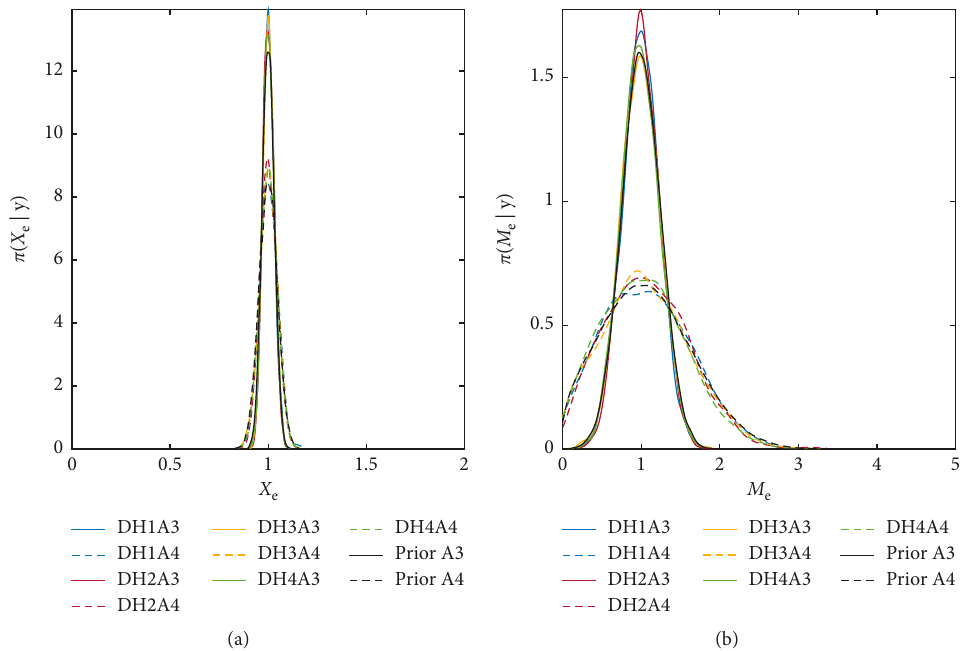
Figure 8: Anomaly scenarios A3 and A4. Prior covariance matrix with λ